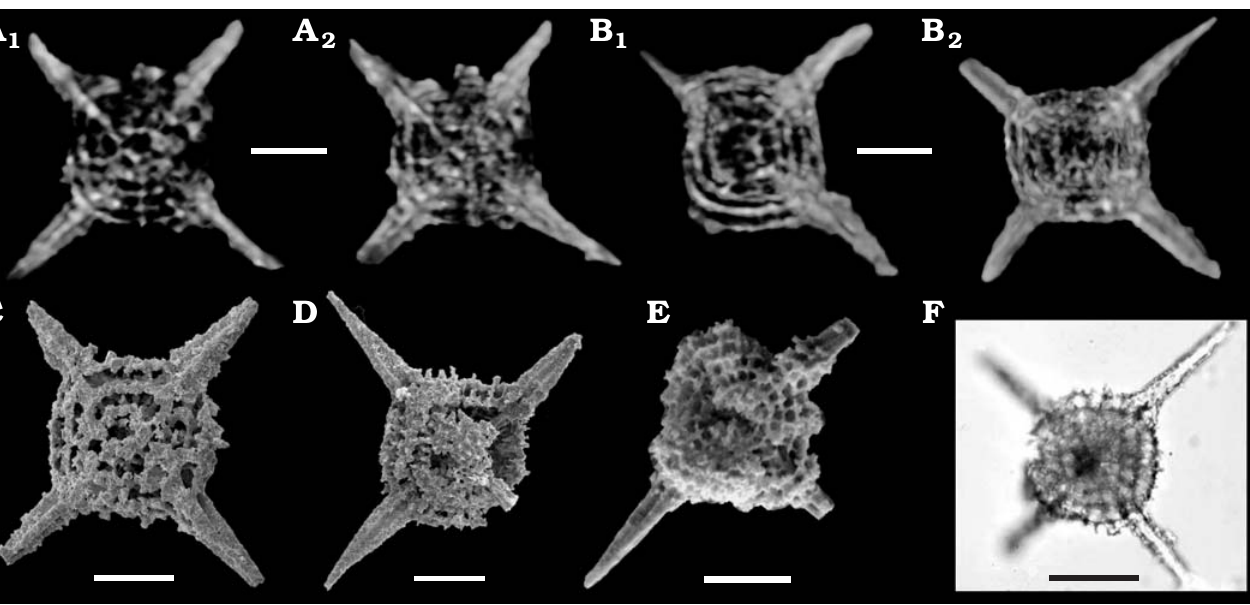
Fig. 2. Micro-XCT cross-sectional images (A, B), SEM micrographs (C–E), and TLM micrographs (F) of the spumellarian Tetraspongodiscus stauracan- thus Feng in Feng et al., 2006 from Changhsingian of the Rencunping section (A–D) and Dongpan (E), South China and upper Capitanian of West Texas, USA (F). A . LGFEC SR 33-201. B . LGFEC SR 33-202. C . LGFEC SR 36-011. D . LGFEC SR 33-022. E . DP 4/4860 (from Feng et al. 2006; copyright is permitted from Elsevier). F . S3-2A (from Noble and Jin 2010). Different cross sections show clear hoops with few primary beams and a possible median bar (A 1 and B 1 ), the centrical internal spicule (A 2 ), and the embedded proximal part of the main spines (B 2 ). Scale bars 50 μ